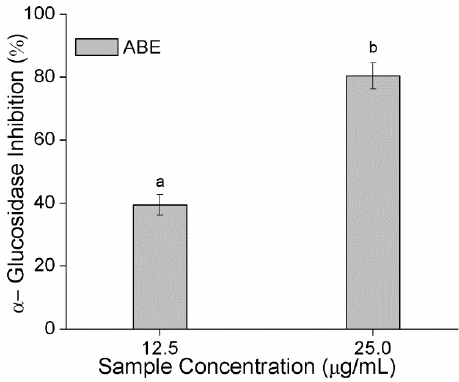
Figure 4. Effect of PAs from ABE on the inhibition of α-glucosidase activity. Values labeled with different letters (a–b) are significantly different from each other ( p < 0.05). The symbols represent mean ± SD.